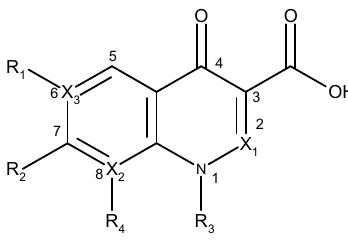
Figure 2. The general structure of 4-quinolones.